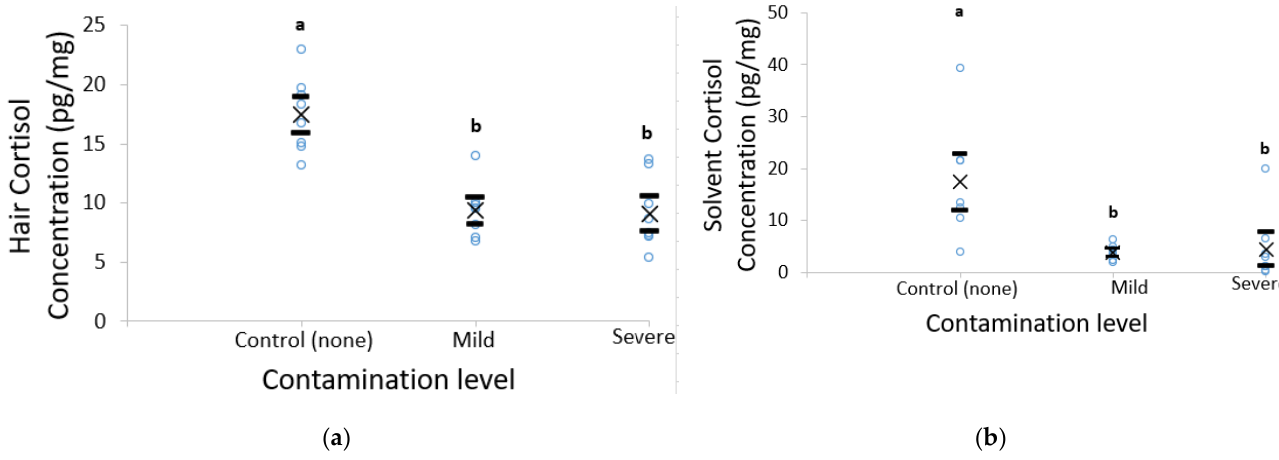
Figure 3. Hair ( a ) and solvent ( b ) cortisol concentrations (pg/mg) of hair receiving no contamination (control) or mild and severe contamination following three methanol washes ( n = 8 per treatment). Different letters denote significant differences between treatment groups ( p < 0.05); means are denoted by ×, and 95% confidence intervals are denoted by black horizontal lines. Table 2. Concentrations (pg/mg) of DHEA in the hair and wash solvent of the control (clean), mild, and severely contam- inated (mixture of feces and urine) grower swine hair ( n = 16/treatment) following three 3 min methanol washes. Data are expressed as the mean ± SEM ( n = 8 per treatment). No statistical differences were present.